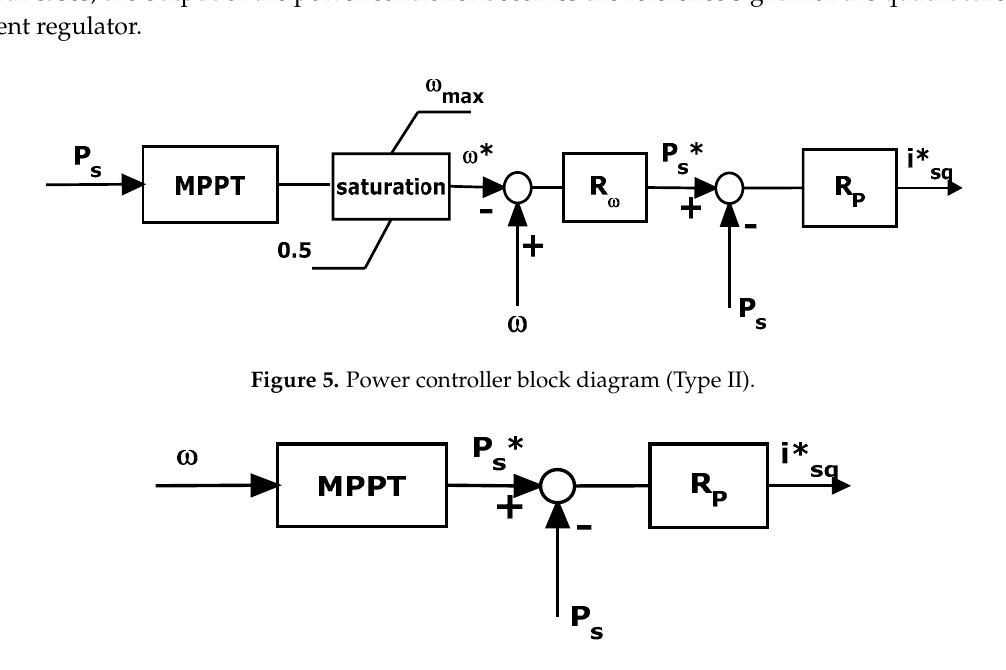
Figure 5. Power controller block diagram (Type I). MPPT: maximum power point tracking. Figure 6. Power controller block diagram (Type I). MPPT: maximum power point